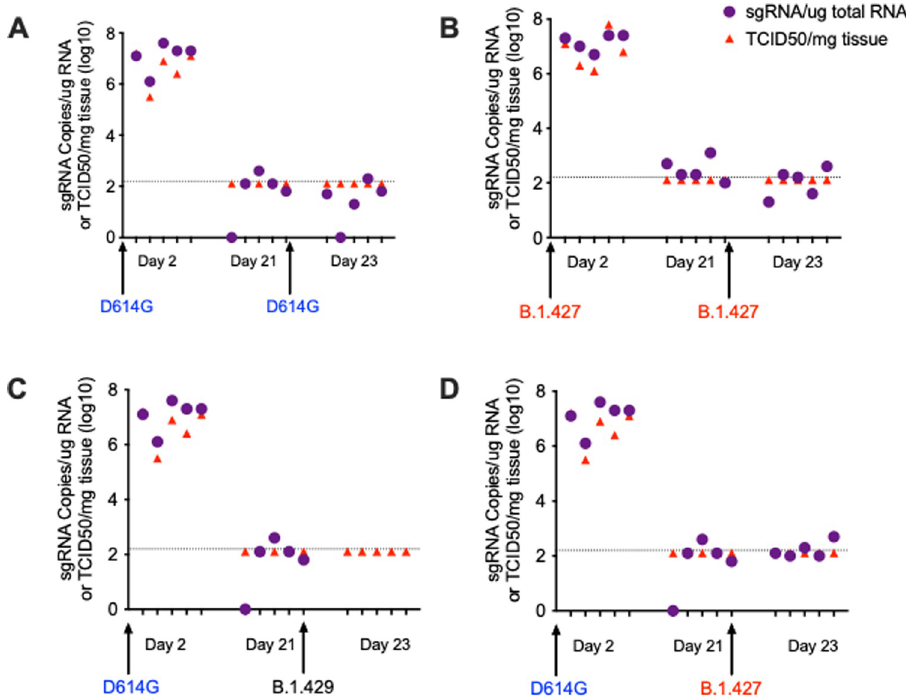
Fig 8. Prior infection with B.1 (614G) protects the lungs of hamsters from subsequent challenge with B.1.427 or B.1.429. A) s gRNA levels and infectious virus titer in lungs of hamsters infected with B.1 (614G) and necropsied at 2 days (N = 5) and 21 days PI (N = 5), and 5 hamsters that were challenged at day 21 PI with homologous B.1 (614G) and necropsied at day 23 PI. B) sgRNA levels and infectious virus titer in lungs of hamster infected with B.1.427 and necropsied at 2 days (N = 5) and 21 days PI (N = 5), and 5 hamsters that were challenged at day 21 PI with homologous B.1.427 and necropsied at day 23 PI. C) sgRNA levels and infectious virus titer in hamster infected with B.1 (614G) and necropsied at 2 days (N = 5) and 21 days PI (N = 5), and 5 hamsters that were challenged at day 21 PI with heterologous B.1.429. D) sgRNA levels and infectious virus titer in hamster infected with B.1 (614G) and necropsied at 2 days (N = 5) and 21 days PI (N = 5), and 5 hamsters that were challenged at day 21 PI with heterologous B.1.427. The limit of quantitation for the PCR assay (125 copies per reaction) is indicated by the dotted line. inoculated intranasally with 10 4 PFU of either B.1 (614G) (N = 10), A.1 (WA-1) (N = 10), B.1.427 (N = 10) or B.1.429 (N = 9) (Fig 9). Six to 8 hours after donor inoculation, a na ï ve “sen- tinel” animal was added to one end of the cage separated from the each donor animal by a bar- rier that prevents large particles but allows smaller particles to pass between the co-housed animals [20]. Oral swabs were collected at day 1 PI from donor animals that were necropsied at Day 7 or 8 PI. Sentinel animals were monitored for virus in oral swabs collected for up to 14 days after exposure. High levels of sgRNA were detected in the oral swabs of all the donor ani- mals at day 1 PI, confirming that they were infected (Fig 9A). It is worth noting that the day 1 PI sgRNA levels in the swabs of B.1.429 infected animals were the highest and the difference compared to WA-1 infected animals was significant (p = 0.0146 mixed effects analysis and post hoc test, Fig 9A). Of the ten sentinels exposed to the B.1.427 donors, all 8 were infected by 2 days post-exposure (PE). By comparison, 100% (10/10) of B.1 (614G) sentinels were infected by 3 days PE and 100% (10/10) of WA-1 sentinels were infected by 5 days PE (Fig 9B). Thus, B.1.427 was transmitted marginally more rapidly than WA-1 and B.1 (614G). In contrast among the B.1.429 sentinels, 7 out of 9 (78%) animals were infected by 3 days PE and 8 of 9 (89%) animals were infected by 5 days PE (Fig 9B). Thus, B.1.427 transmits between hamsters marginally more efficiently than B.1 (614G) and WA-1, while B.1.429 transmits marginally